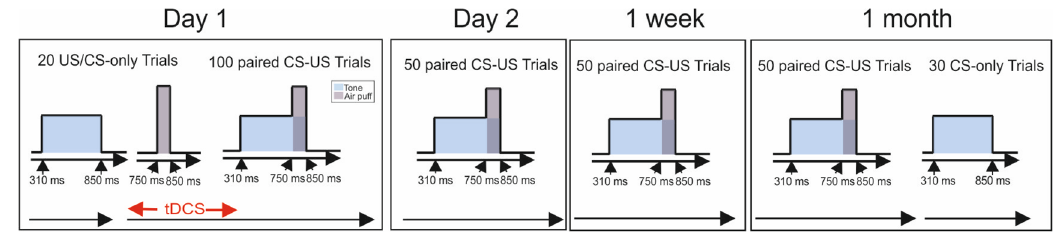
Figure 5. Experimental protocol. At the beginning of day 1, 10 CS-only trials and 10 US-only trials were presented in a pseudorandom sequence (pseudo-conditioning), followed by 100 paired CS–US trials. tDCS was started after the pseudo-conditioning phase and lasted throughout the first 50 paired CS–US trials. On days 2, 8 (1 week) and 29 (1 month), 50 paired CS–US trials were given. On day 29 (1 month) the 50 paired CS–US trials were followed by 30 CS-only extinction